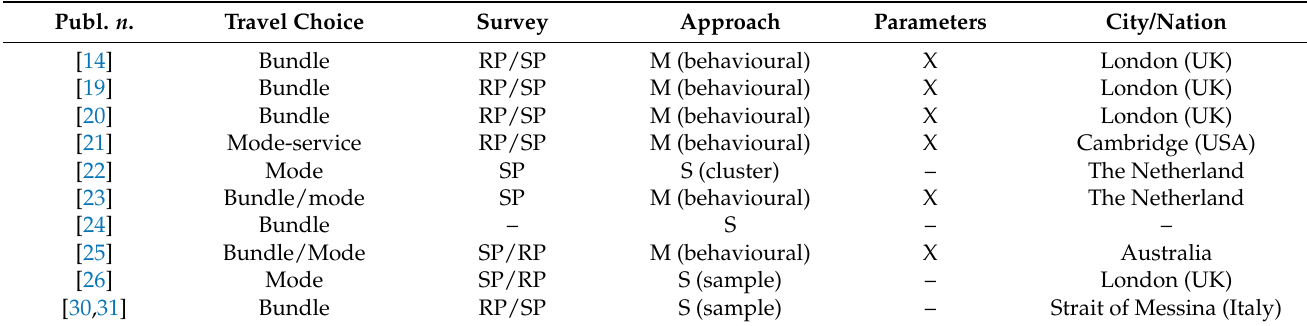
Table 1. Literature studies about demand of